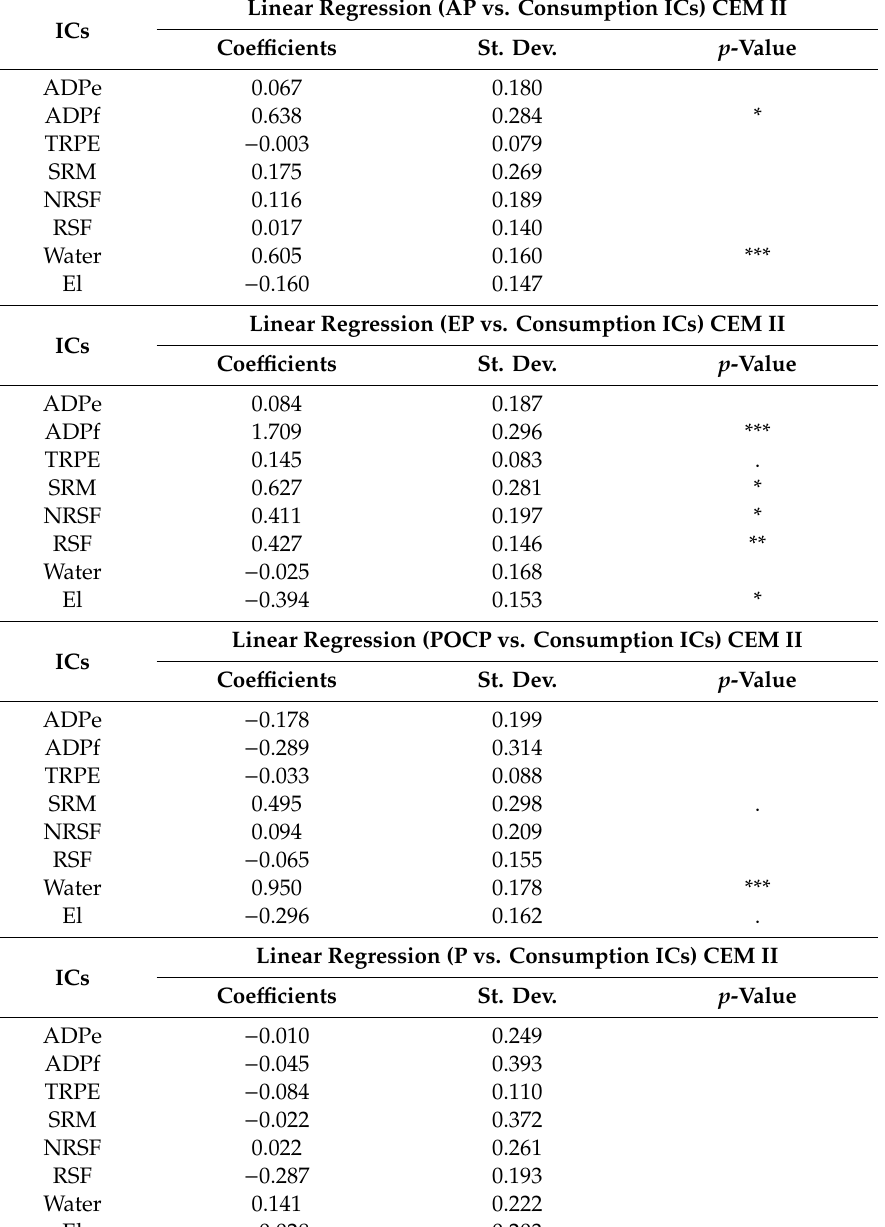
Table 17. Linear regression summary—CEM